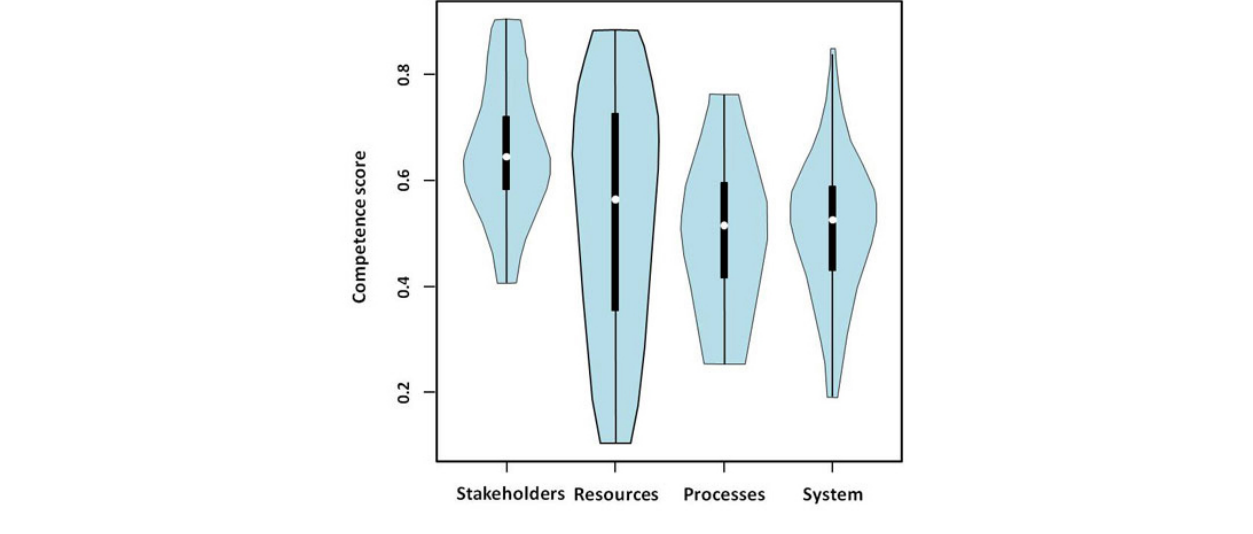
Fig. 6 . Violin plots of the competence scores for stakeholders, resources, processes, and the whole system across all groups holding consensus mental models (or mental models in which weak agreement was observed). The white dot represents the median value, and the black bar the 20th to 80th percentiles of the data. The light blue ellipses represent the probability density of the data at different